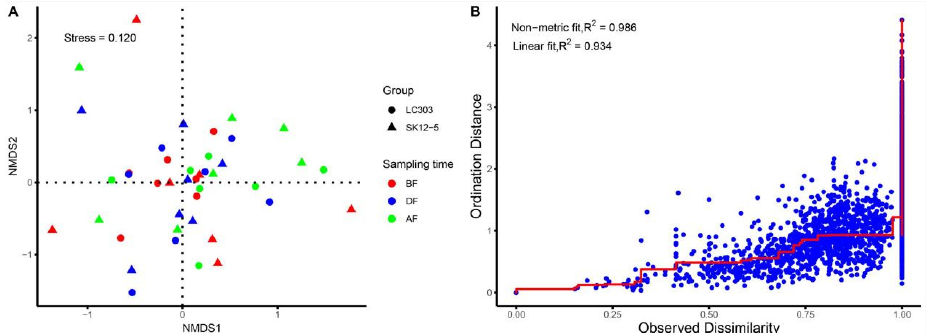
Figure 2. ( A ) Nonmetric Multidimensional Scaling (NMDS based on Bray–Curtis distance) plot of community structures of arthropods for three main growth stages in SK12-5 and LC303 maize fields. Triangles indicate SK12-5 ( Bt ) maize fields, and circles indicate LC303 (non- Bt ) maize fields. Different colors indicate the three main growth stages: red indicates Before Flowering (BF) stage, blue indicates During Flowering (DF) stage and green indicates After Flowering (AF) stage. ( B) NMDS Shepard plot. The species richness ( S ), Shannon–Wiener diversity index ( H ′ ) and evenness ( J ) indexes of NTAs in Bt maize fields in the BF, DF and AF maize growth stages were all higher than those in non- Bt maize fields, while the Simpson’s dominant concentration ( C )